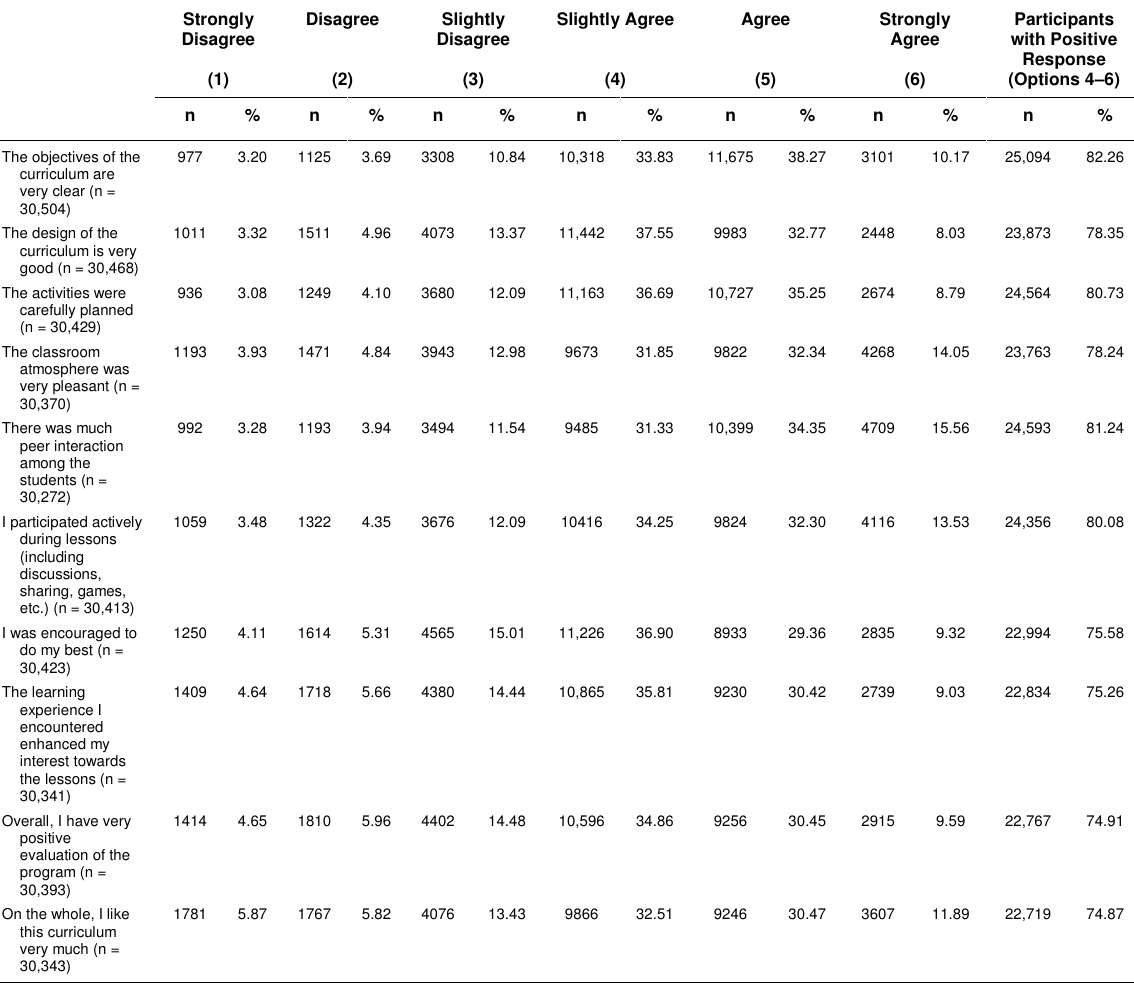
Summary of the Views of the Program Participants on the